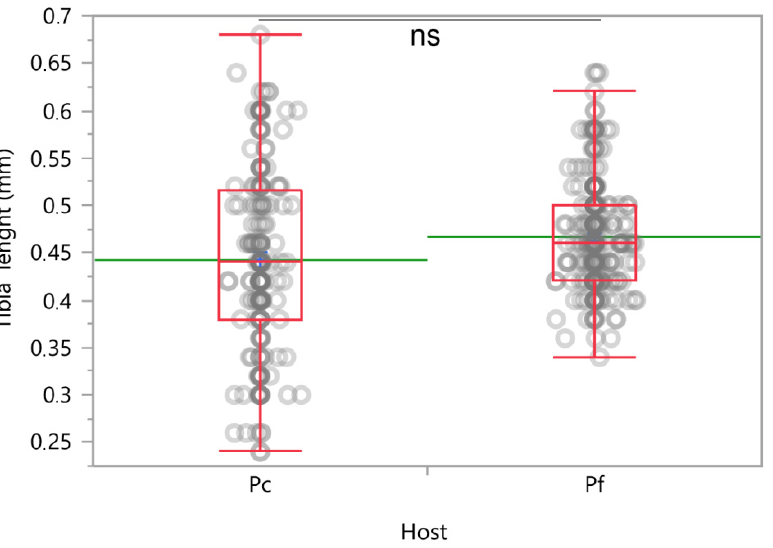
Figure 8. Hind tibia length of Anagyrus vladimiri emerged from Pseudococcus comstocki (Pc) and